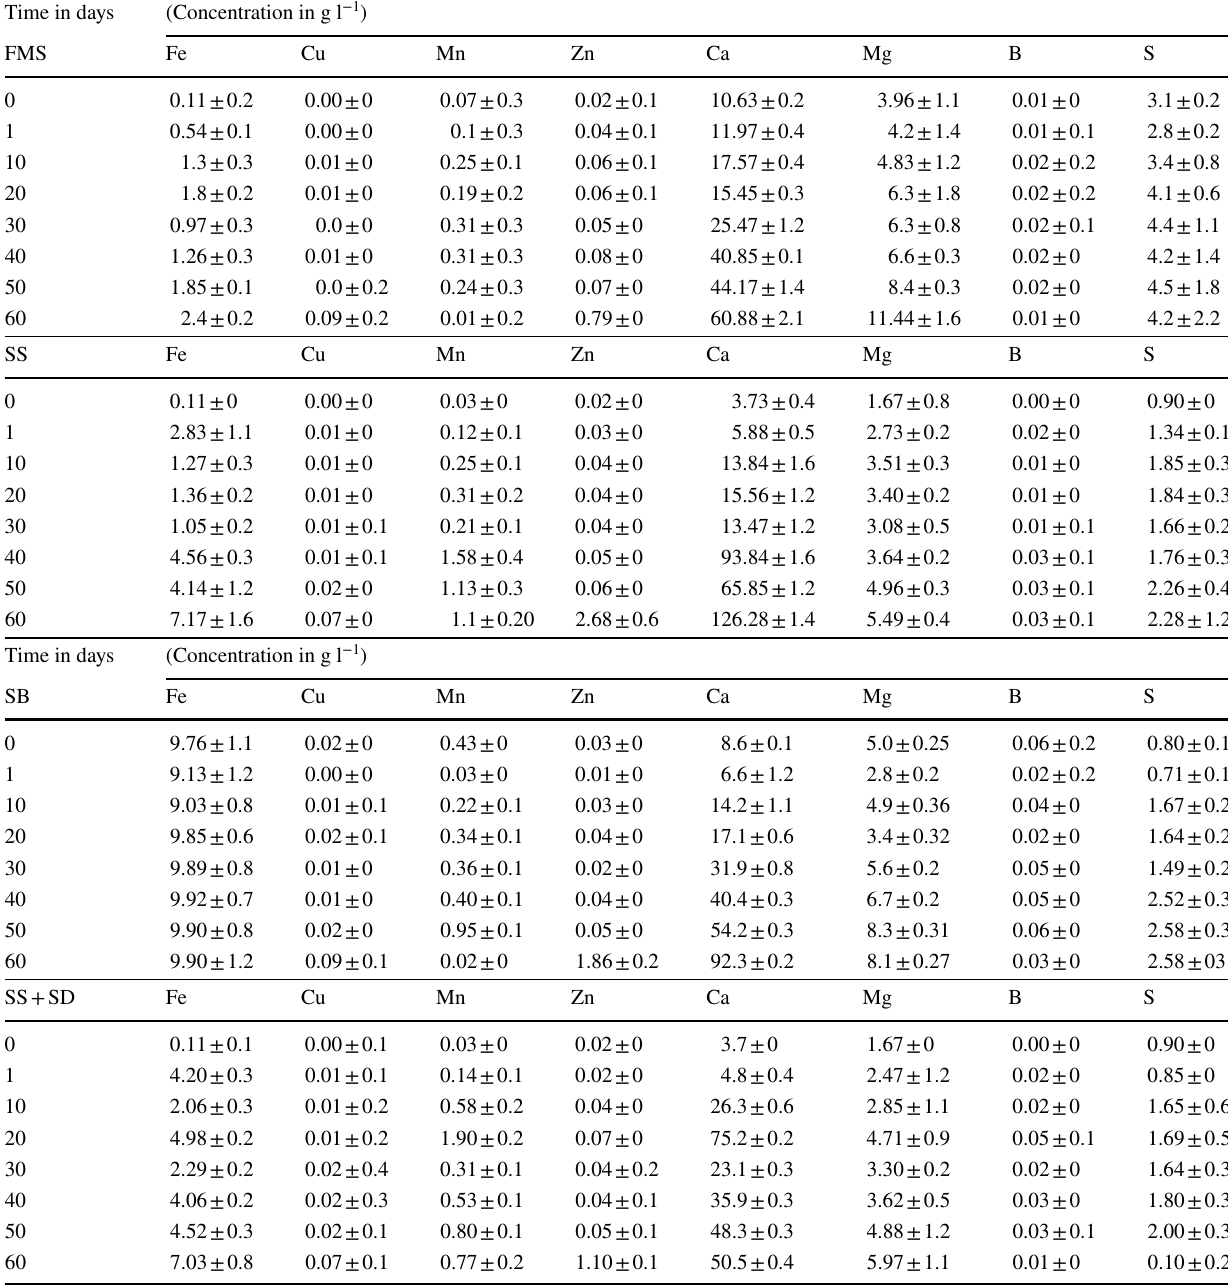
Table 2 Elemental dynamics (in g l −1 ) in finger millet straw (FMS), sorghum straw (SS), soybean straw (SB) and sorghum straw (SS) + saw dust compost pits (SS + SD) Time in